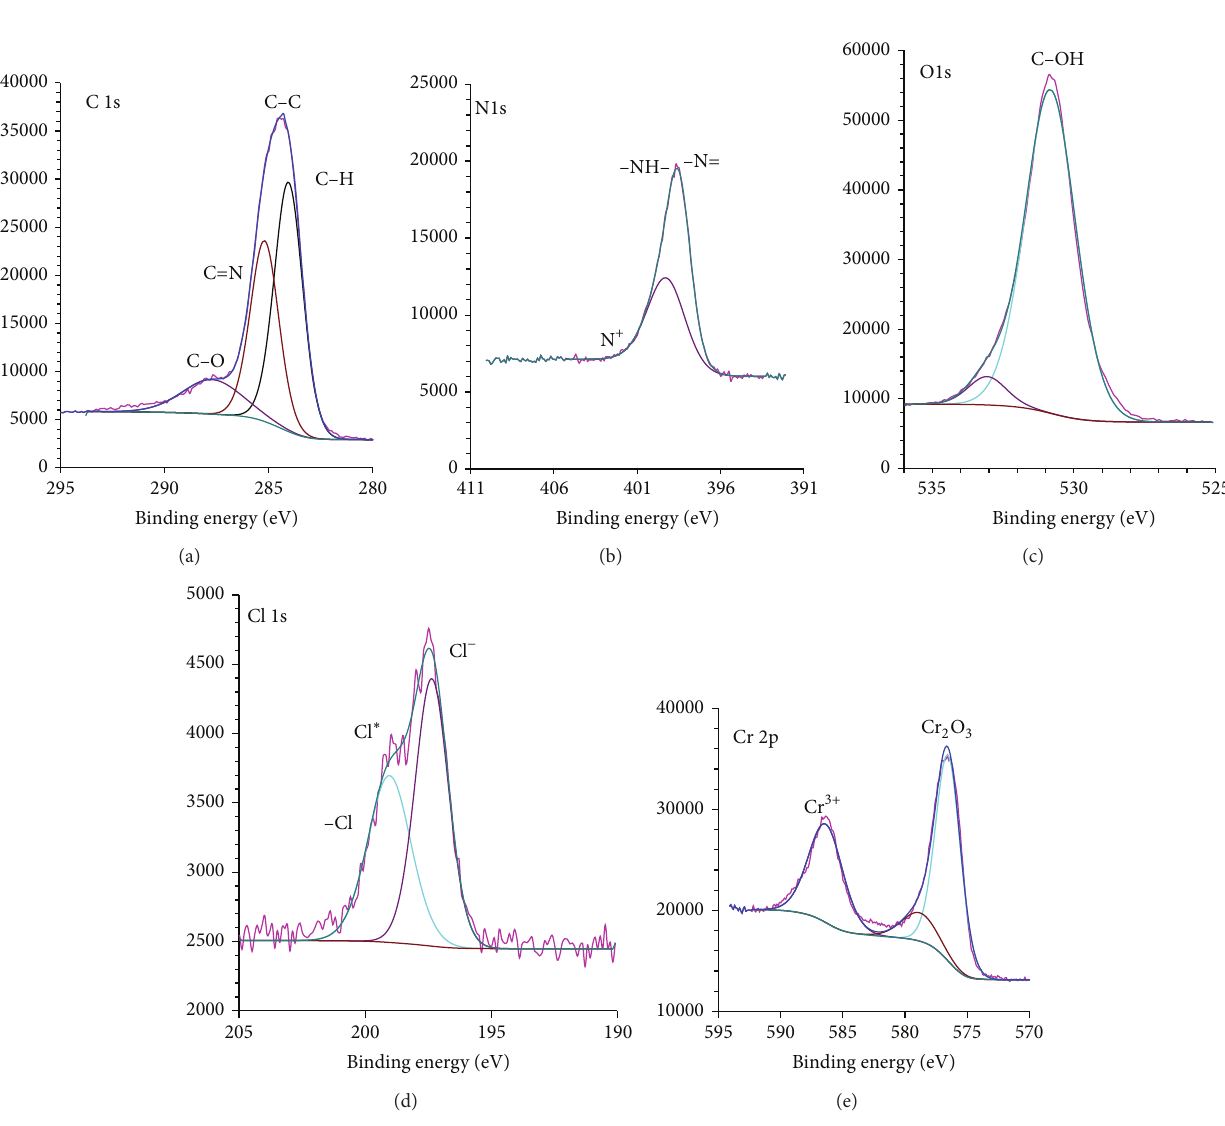
Figure 11: X-ray photoelectron spectroscopy (XPS) spectra of